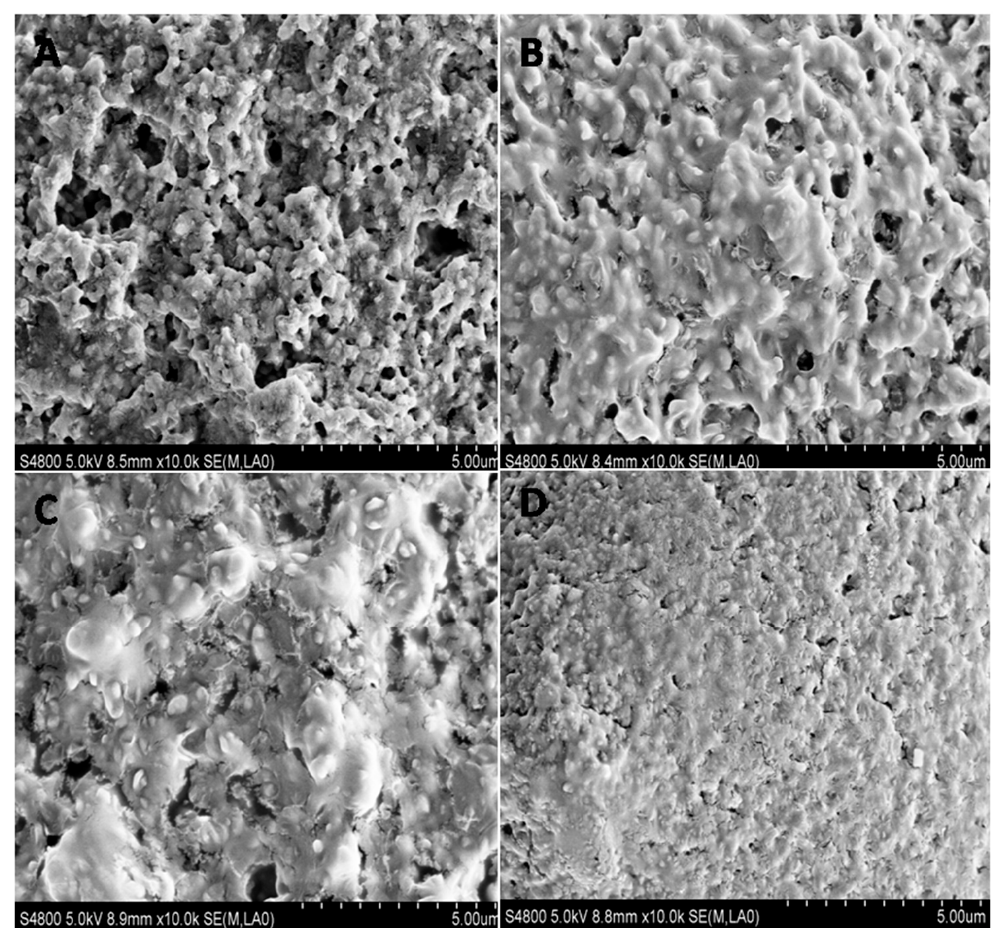
Figure 4. Scanning electron microscopy pictures of growing UPEC CFT073 biofilm. Biofilm